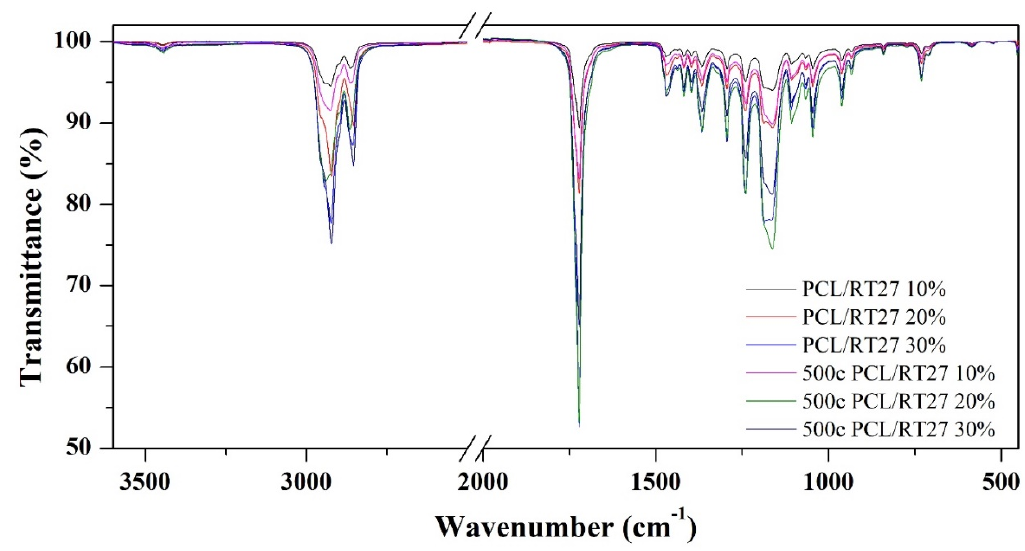
Figure 8. FT-IR spectra before and after the thermal cycling of RT27 CSS-PCM until 30 wt.%.